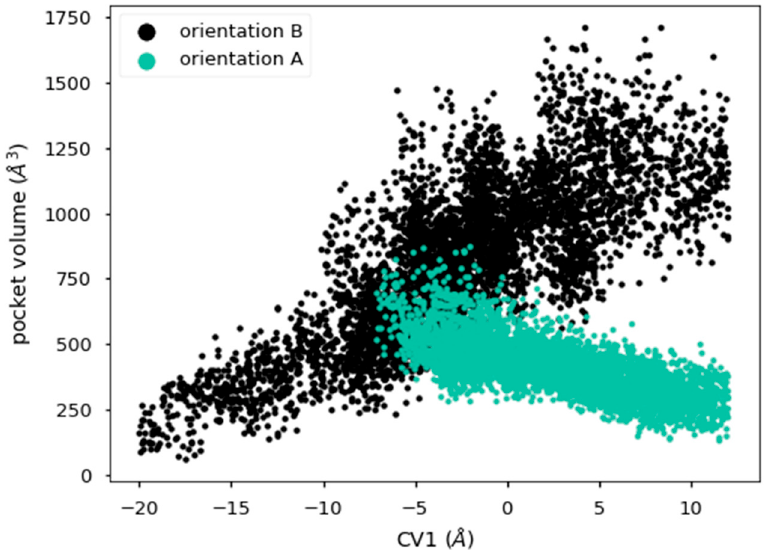
Figure 7. Cavity volume for each position of the ligand along the diffusion axis during metadynamics simulations. Color of orientation A was changed for visualization purposes.